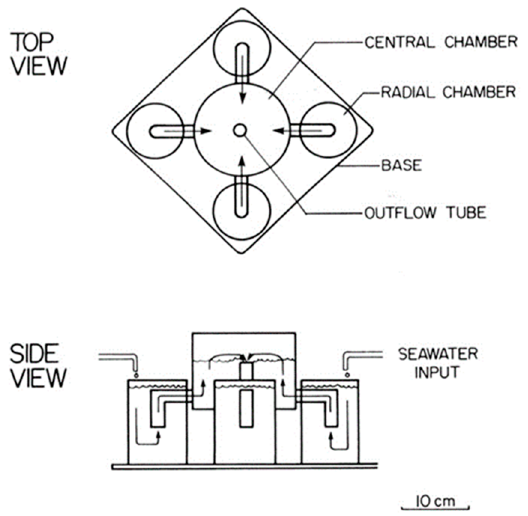
Figure 1. Four-chambered choice apparatus .